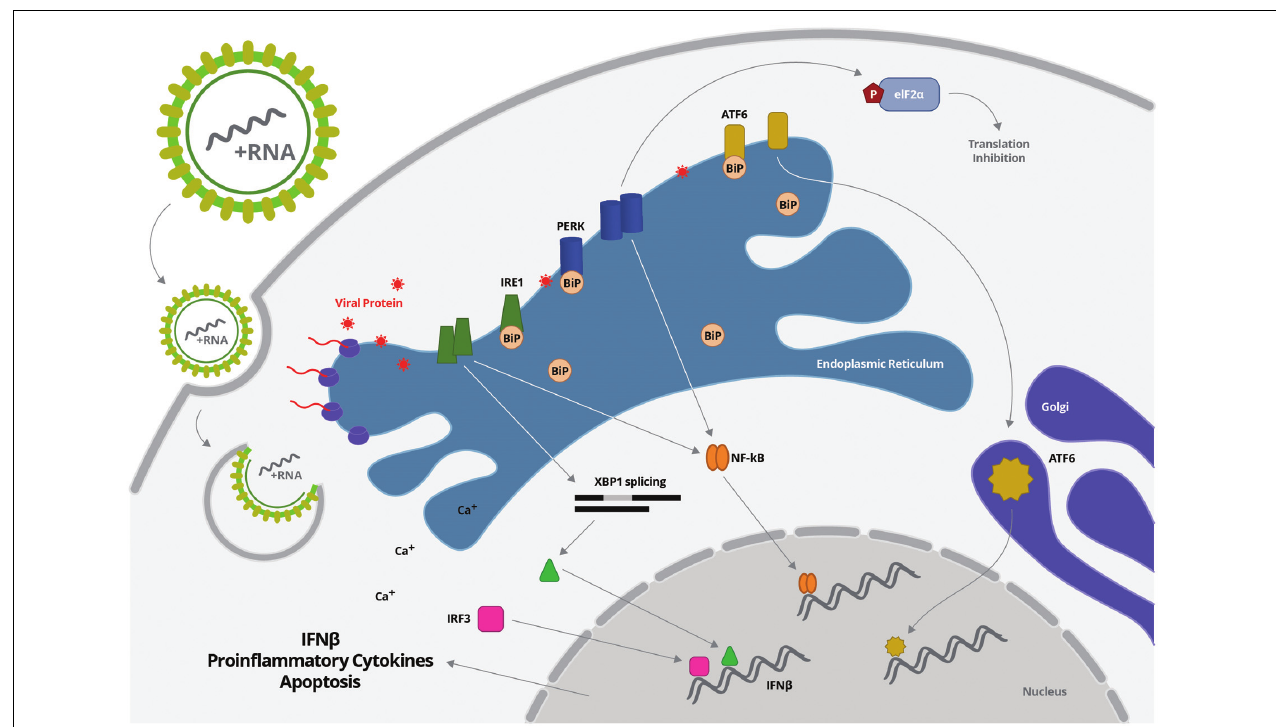
FIGURE 2 | Flavivirus entry and uncoating is followed by virus RNA translation, which takes place mostly in association to ER membrane. Increased protein synthesis may disturb ER homeostasis, inducing unfolded protein response, characterized by BiP transiently dissociation and release of PERK, ATF6, and IRE1. BiP releasing from PERK or IRE1 allows the homodimerization of each protein through their luminal domain, which induces their autophosphorylation and subsequent activation. PERK or IRE1 can activated NF- κ B. IRE1 also mediated XBP1 splicing, generating functional spliced XBP1 (XBP1s), which is translocated to the nucleus and interact with a conserved site downstream of ifnb1 gene, enhancing IFN- β production. Activation of PERK inhibits protein synthesis through phosphorylation of the eIF2- α . In parallel, the release of BiP from ATF6 promotes the translocation of ATF6 from ER to the Golgi apparatus, where it is cleaved and activated. Activation of ATF6 stimulates the transcription of genes encoding chaperones that refold misfolded